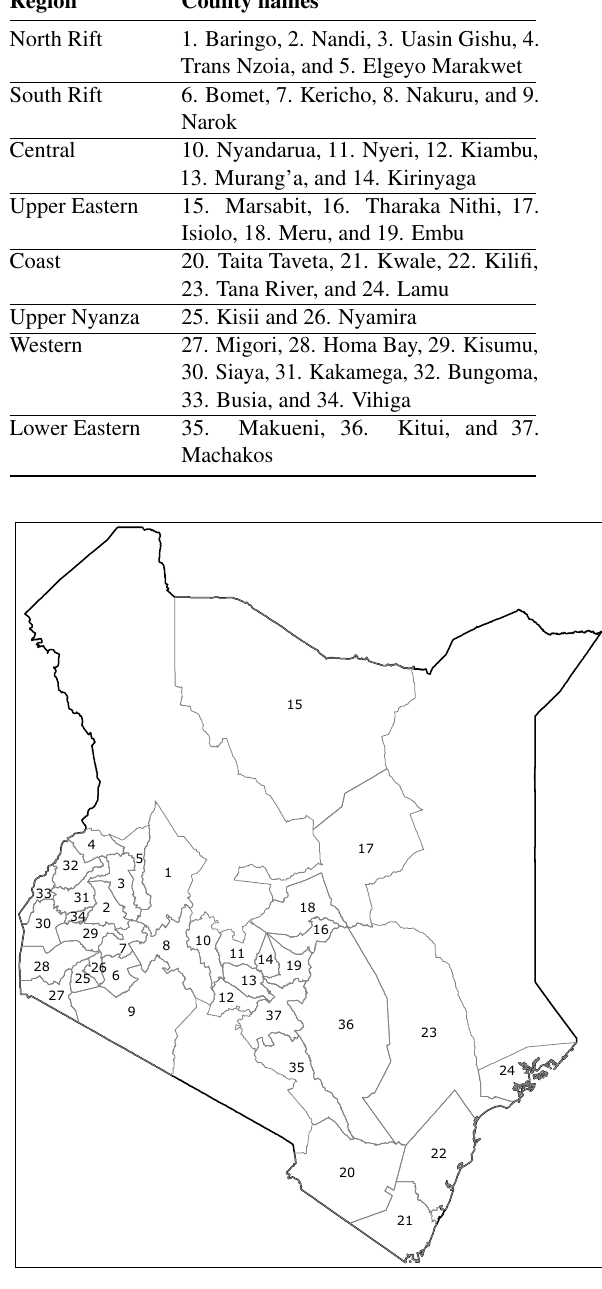
Figure 1. Maize growing counties in Kenya used for yield predic- tion. The number labels correspond to County names in Table 1. County level maize yield data for 2010 to 2017 was obtained from